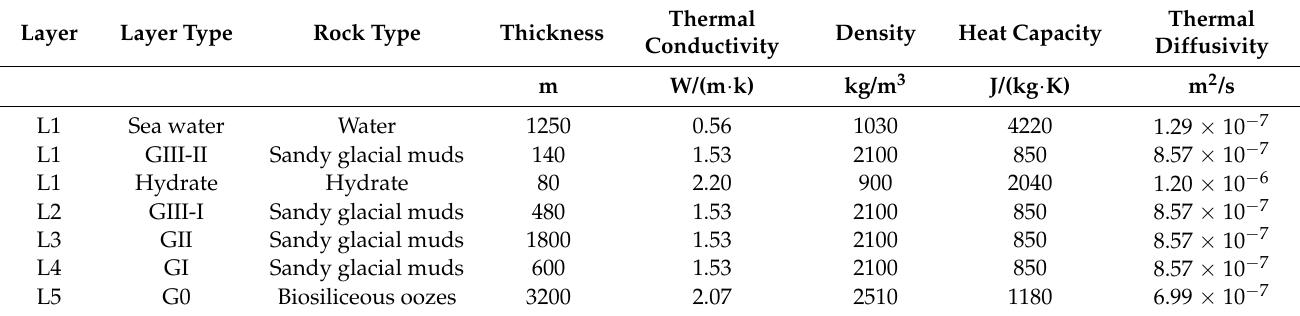
Figure 2. Geological model of the Håkon Mosby Mud Volcano (HMMV). The fluid storage tank is located in the fifth layer. The mud volcano can be traced to a depth of 3.1 km below the seafloor. Biosiliceous oozes originated from pre-glacial period (layer 5), which flowed upward and erupted from the seafloor forming the mud volcano structure. Table 1. Geophysical parameters of the HMMV model. Based on the results of the submarine heat flow survey and hydrate drilling in the HMMV conducted by the researchers, the physics parameters of each layer in the mud volcano geological model were established. G0: pre-glacial unit; GI-GIII: glacial units; GI, GII, GIII-I and GIII-II, correspond to thicknesses 600 m, 1800 m, 480 m and 140 m, respectively (the sources of the petrophysical, thermodynamic, sedimentary and hydrate parameters are from [8,10–12,15,37]).